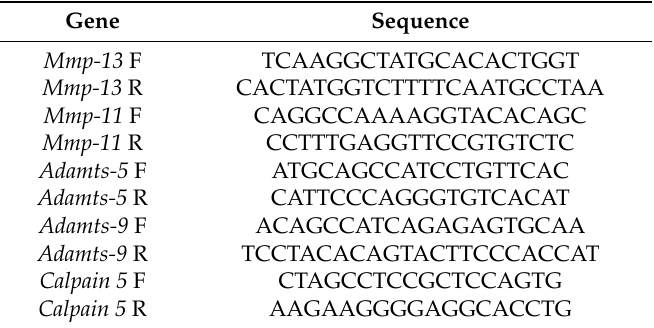
Table 1. Primer sequences for qPCR